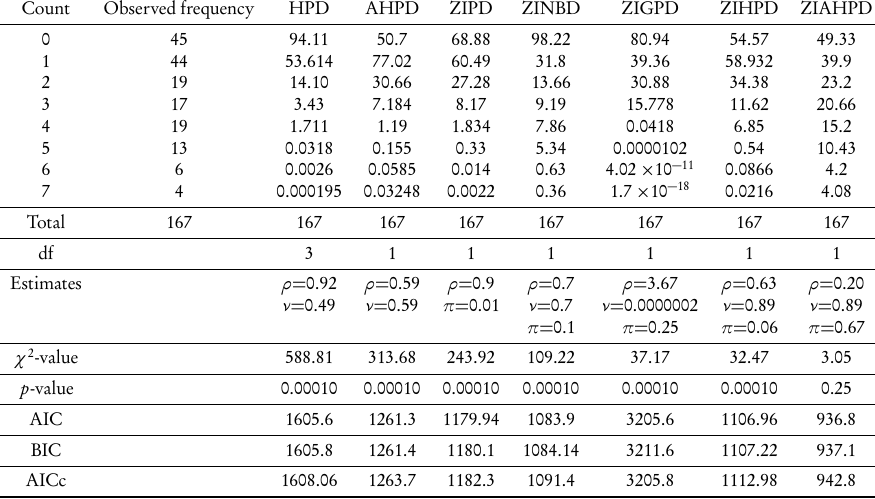
Distributions of currency and banking crises (Giles et al. , 2010) and the expected frequencies computed using hyper-Poisson, alternative hyper-Poisson, zero-inflated Poisson, zero-inflated negative binomial, zero-inflated generalized Poisson, zero-inflated hyper-Poisson and